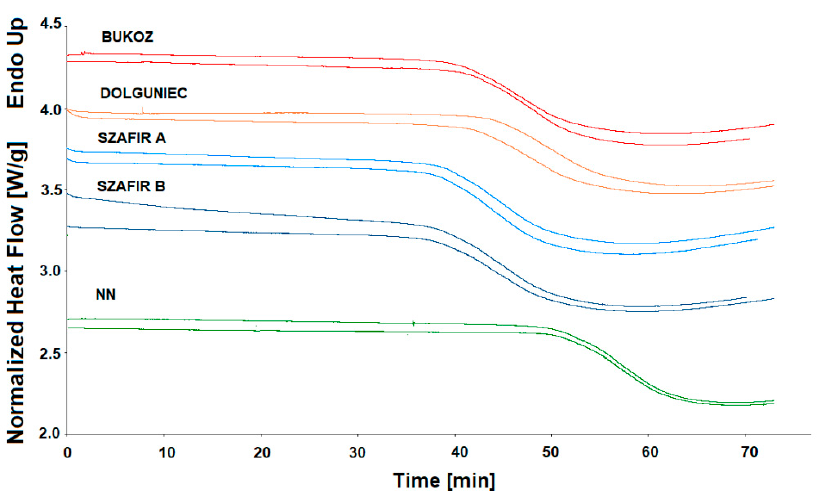
Molecules 2021 , 26 , x FOR PEER REVIEW